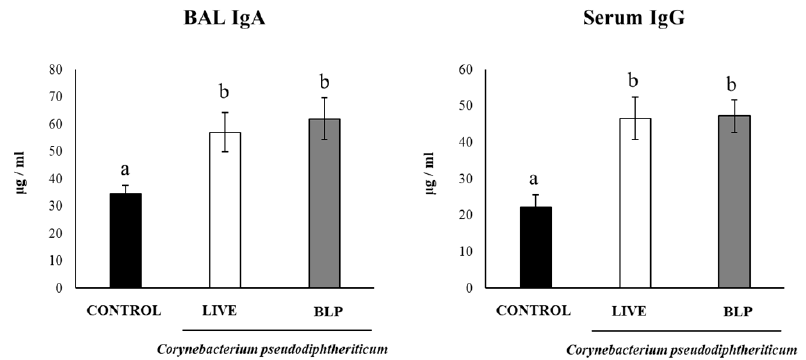
Figure 3. Humoral immune response induced by the immunization with the pneumococcal conjugate vaccine (PCV) plus Corynebacterium pseudodiphtheriticum 090104 or its bacterium-like particles (BLPs) in infant mice. Swiss albino infant mice (3 weeks old) were immunized by the nasal route with PCV or PCV plus C. pseudodiphtheriticum 090104 or it BLPs on days 0, 14, and 28. Five days after the last immunization (day 33), serum and broncho-alveolar lavage (BAL) samples were obtained for the determination of specific antibodies. Concentration of PCV-specific IgA in BAL and IgG in serum were determined with ELISA. Results represent data from three independent experiments ( n = 6) and are expressed as mean ± standard deviation. Letters indicate significant differences between the groups ( p <